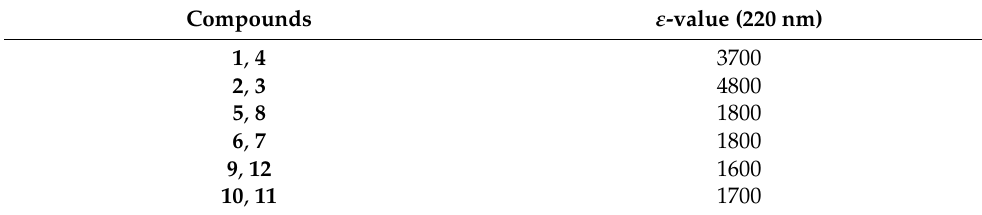
Figure 1. Synthetic library of 2,5-diketopiperazines containing all possible stereoisomers of ( a ) cyclo(Phe-Pro) ( 1 – 4 ), ( b ) cyclo(Leu-Pro) ( 5 – 8 ), and ( c ) cyclo(Val-Pro) ( 9 – 12 ). Table 1. UV ε -values of DKP stereoisomers in methanol (spectroscopic grade).